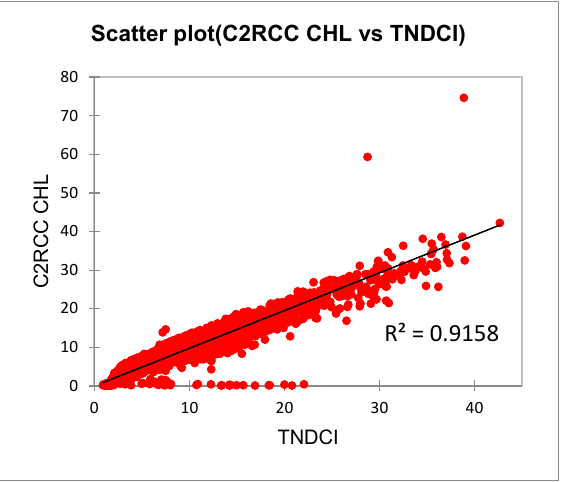
Figure 6. Scatterplot between C2RCC chlorophyll-a and TNDCI values for 29 March 2020